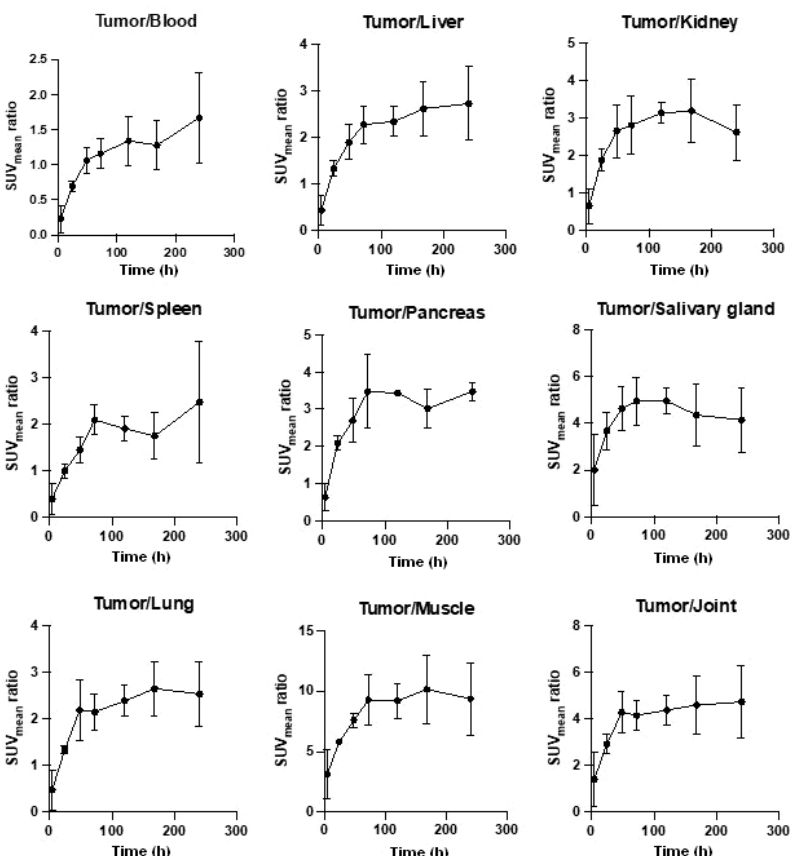
Figure 6. Quantitative assessment of KB-3-1 tumor-to-organ ratios in CB17 SCID mice after the i.v. injection of [ 52 Mn]Mn-DOTAGA-bevacizumab. SUV: standardized uptake value. Data are shown as mean ± SD and obtained from n = 5 animals/time point.